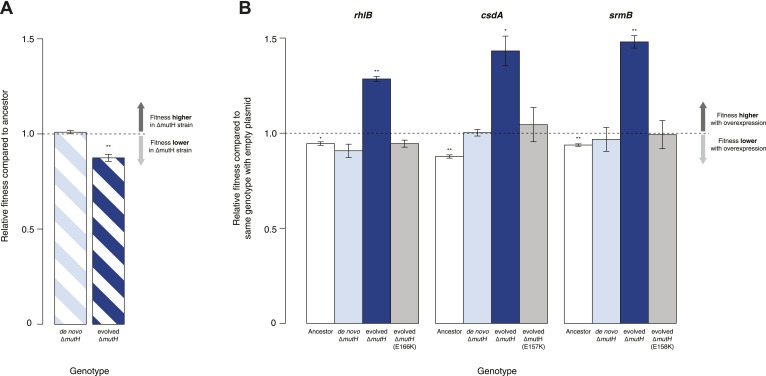
Relative fitness of Escherichia coli MG1655-derived strains.(A) Relative fitness of the evolved and de novo-constructed ΔmutH strains, each competed against their MG1655 ancestor. (B) Relative fitness of ancestral, evolved, and de novo ΔmutH genotypes overexpressing one of three DEAD box RNA helicases compared with identical strains carrying the empty control plasmid. E166K, E157K, and E158K, bar heights and error bars are as described in Figure 1. **p < 0.01, *p < 0.05 (one-sample t-test). Additional results for competitions terminated in the mid-exponential phase (after 2 hr) are shown in Figure 2—figure supplement 1.